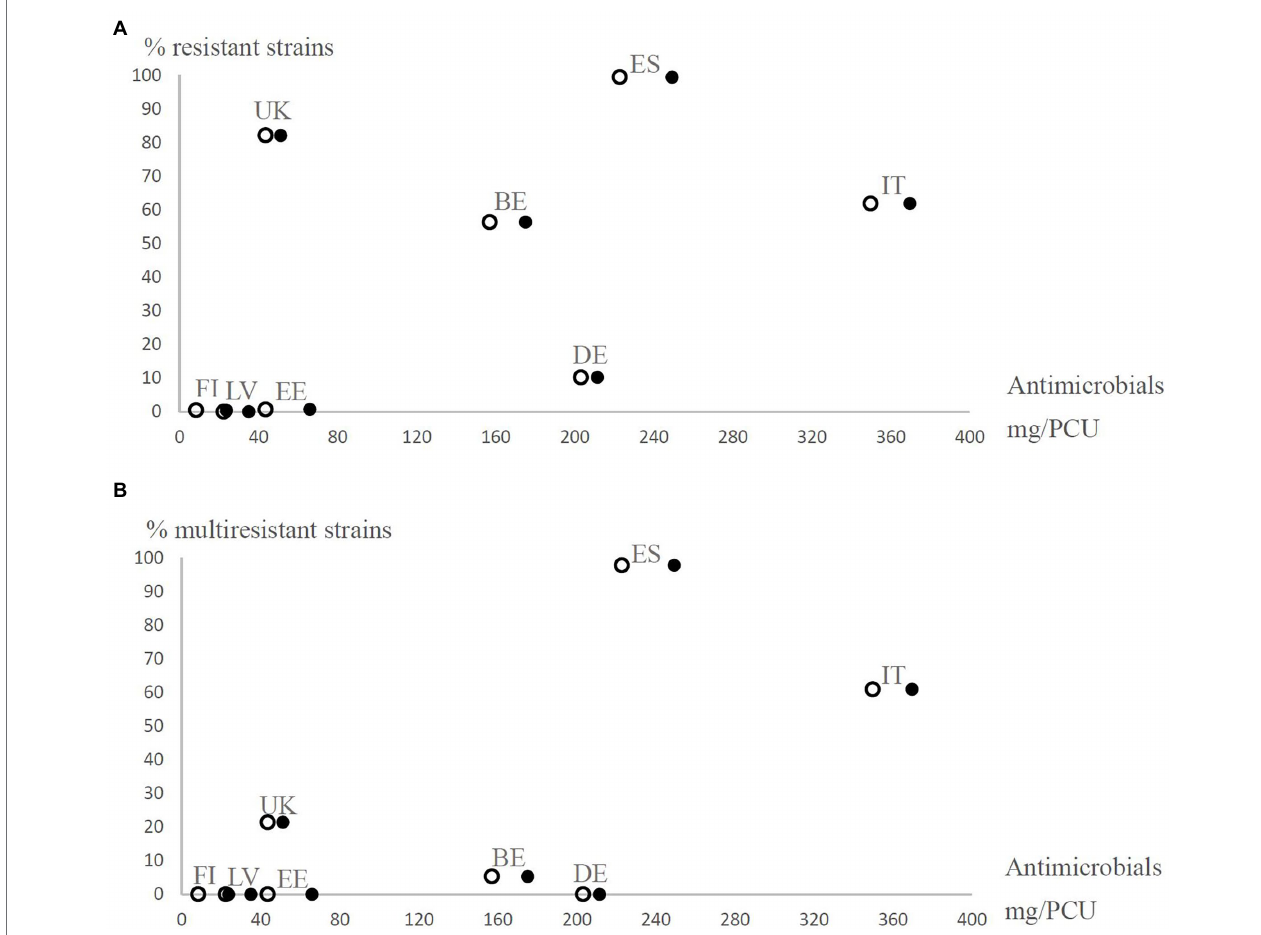
FIGURE 1 | Prevalence of resistant (resistance to at least one antimicrobial agent excluding ampicillin; A ) and multiresistant (resistance to at least two antimicrobial agents excluding ampicillin; B ) Yersinia enterocolitica 4/O:3 strains from different European countries (BE, Belgium; DE, Germany; EE, Estonia; ES, Spain; FI, Finland; IT, Italy; LV, Latvia; and UK=United Kingdom) observed in the present study in relation to the estimated number of antimicrobials sold for treating production animals in mg per population correction unit (mg/PCU) in 2011. Open circles represent orally administered antimicrobials and closed circles represent all antimicrobials. The proportions of oral solutions, oral powders, and premixes as percentages of total sales of antimicrobial agents in each country [European Medicines Agency (EMA), 2013] were used as coefficients to estimate how many mg/PCU of antimicrobials were administered orally for production